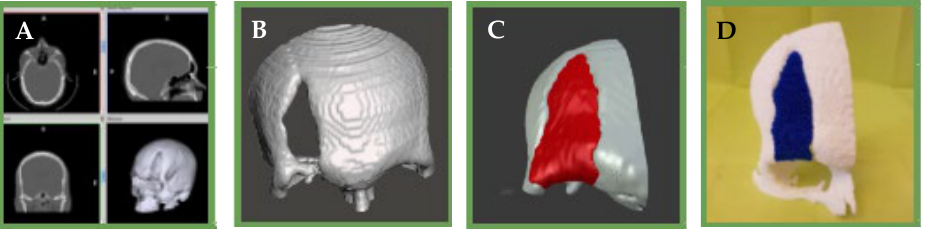
Figure 13. ( A ): Tomographic image of the patient’s skull ( B ): 3D reconstruction of the skull and the bone defect and surrounding tissue ( C ): 3D computational model of the bone defect ( D ): 3D impression of the scaffold and surrounding bone tissue.